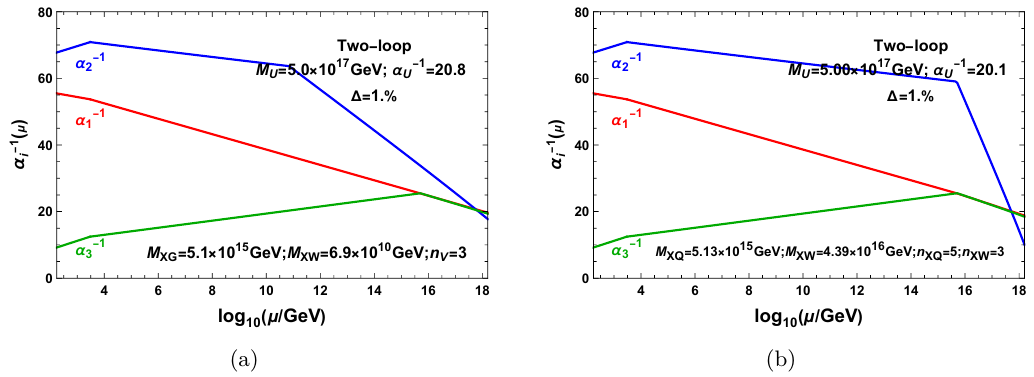
Figure 15 . Two-loop evolution of gauge couplings for the Model 10 with vector-like particles. In the model, k = 50 × 5 and k = 4 . The string-scale gauge coupling relation can be achieved by Y 2 47 3 9 adding 3( XG + XW ) (a) and 5( XQ + XQ ) + 3 XW